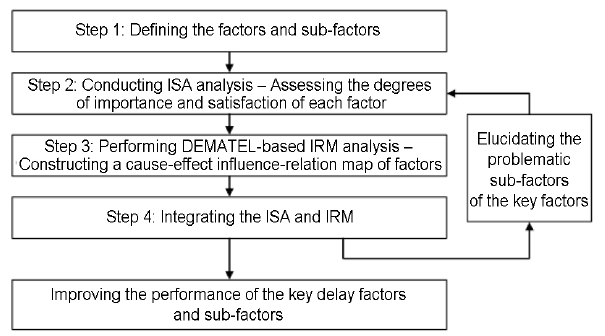
Fig. 1. Steps of proposed